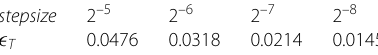
Table 1 Computational error at endpoint T = 1 for Example 5.1